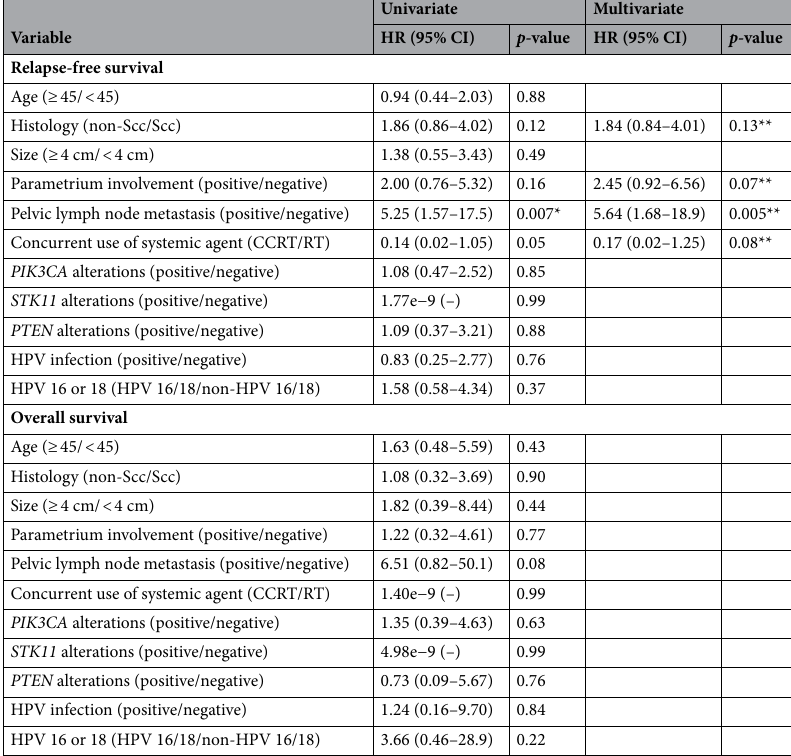
Table 3. Hazard ratios for relapse-free survival and overall survival in cervical cancer. Scc squamous cell carcinoma, CCRT concurrent chemoradiation therapy, RT radiation therapy, HPV human papillomavirus. *Cox proportional hazard model. **Adjusted for histology, pamametrium involvement, concurrent use of systemic agent, and pelvic lymph metasitasis.